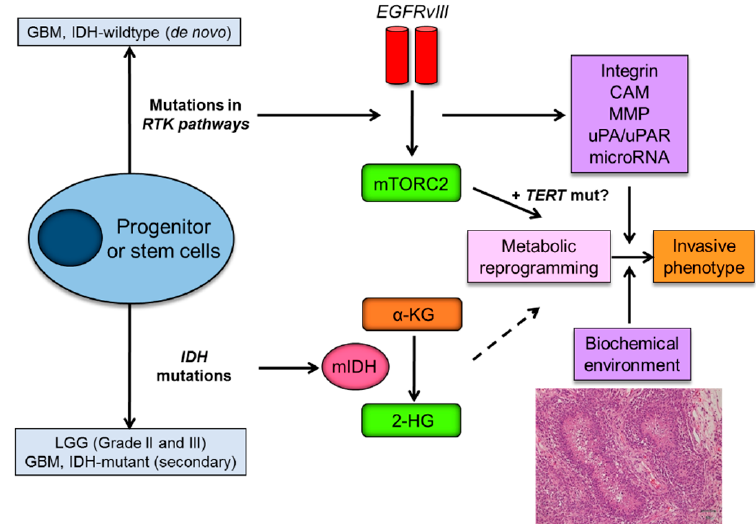
Figure 3. Metabolic reprogramming as a driving force of glioma invasive phenotype. Mutations in IDH that are identified as an early genetic event in grade II/III LGG and secondary GBM, and genetic alterations of key components of the growth factor receptor-PI3K-Akt-mTOR, which are main genetic aberrations in de novo GBM, play an essential role in metabolic reprogramming in diffuse gliomas. Metabolic reprogramming by mTORC2 (also possibly by TERT) could contribute to invasive phenotypes of glioma cells, in combination with pro-invasive molecules produced by EGFR signaling pathways. Biochemical microenvironment such as necrosis (hypoxia) also significantly affects the migratory capacity of the glioma cells. IDH, isocitrate dehydrogenase; LGG, lower grade glioma; GBM, glioblastoma; RTK, receptor tyrosine kinase; EGFRvIII, epidermal growth factor receptor variant III; mTORC2, mammalian target of rapamycin complex 2; mIDH, mutant form of IDH enzymes; α -KG, α -ketoglutarate; 2-HG, 2-hydroxyglutarate; TERT, telomerase reverse transcriptase; mut, mutation; CAM, cell adhesion molecule; MMP, matrix metalloproteinase; uPA, urokinase